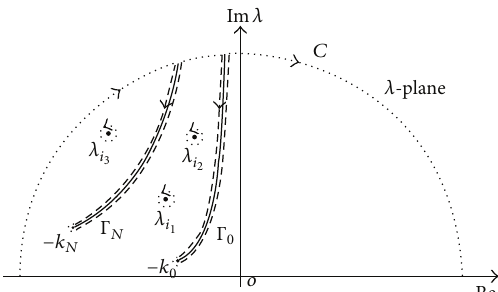
Figure 2: Deformed integration contour for the Sommerfeld Inte-